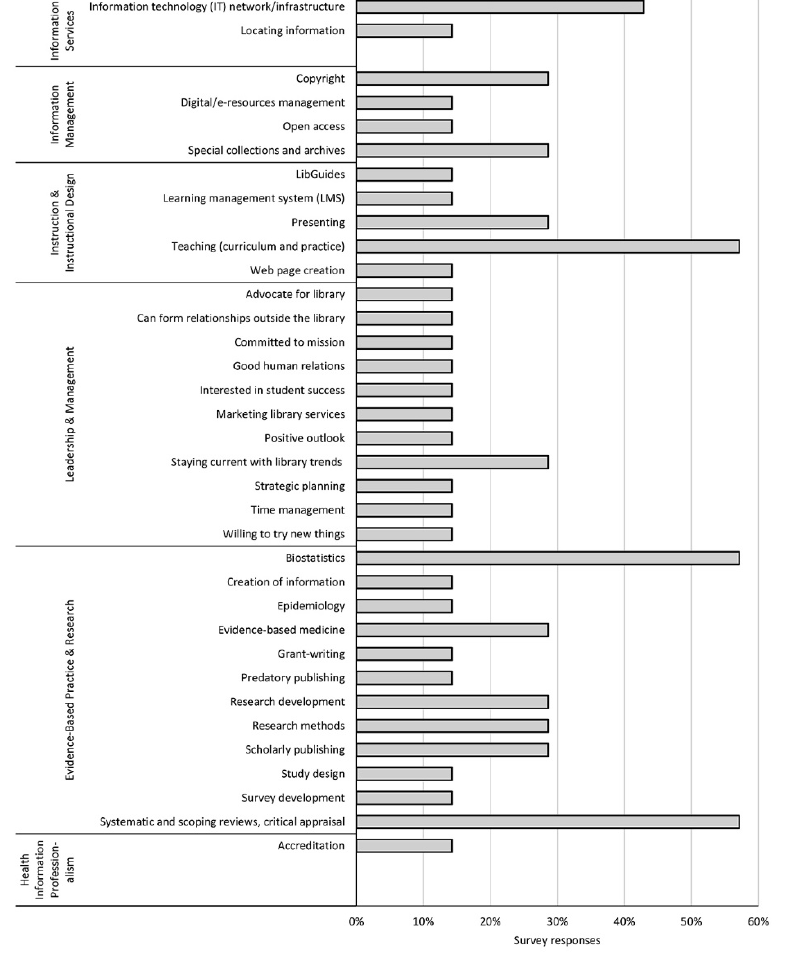
professional staff for these specialized